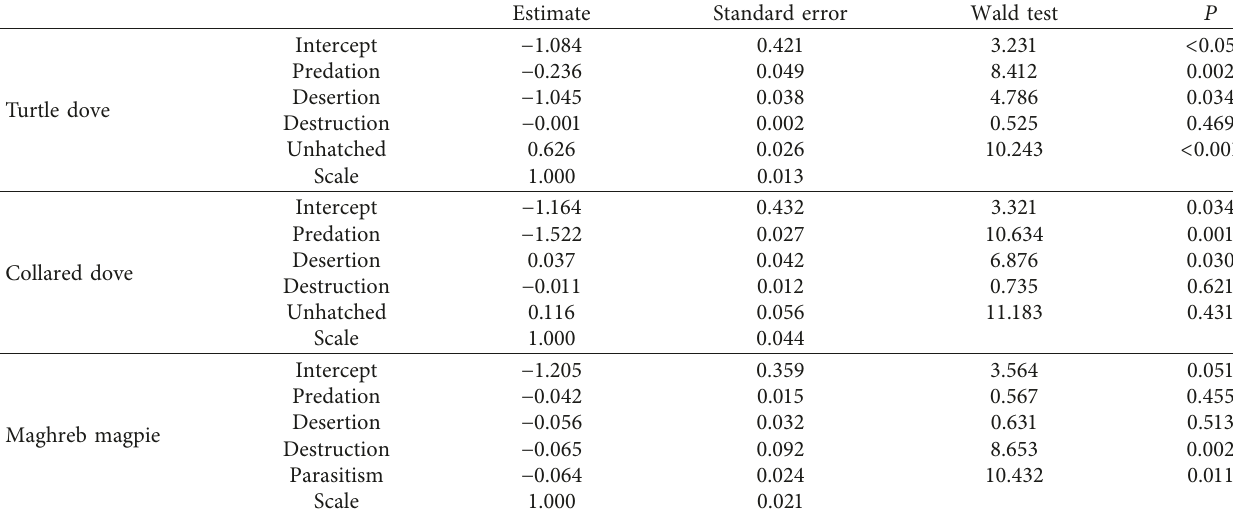
Table 3: Failure causes decreasing the probability to emancipate fledglings of collared dove, turtle dove, and Maghreb magpie. Estimate Standard error